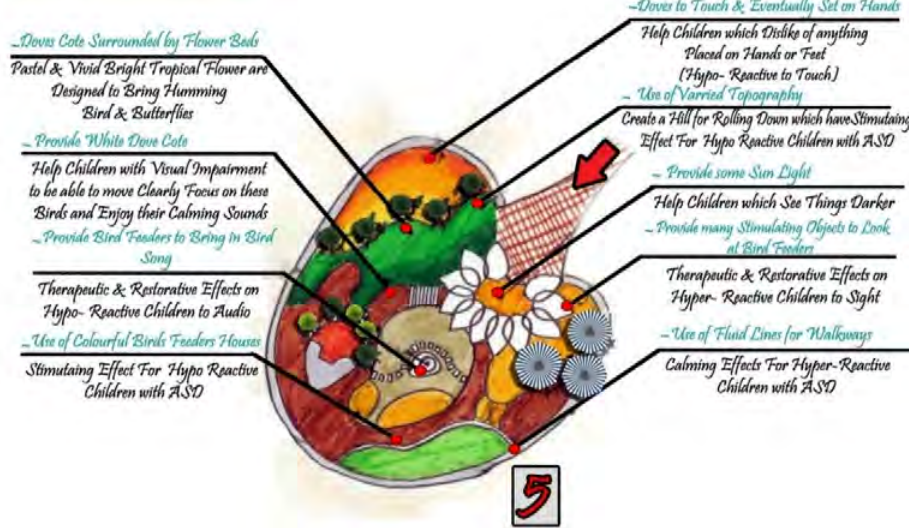
Figure 21. Shows the design consideration for the “Bird Area” Zone